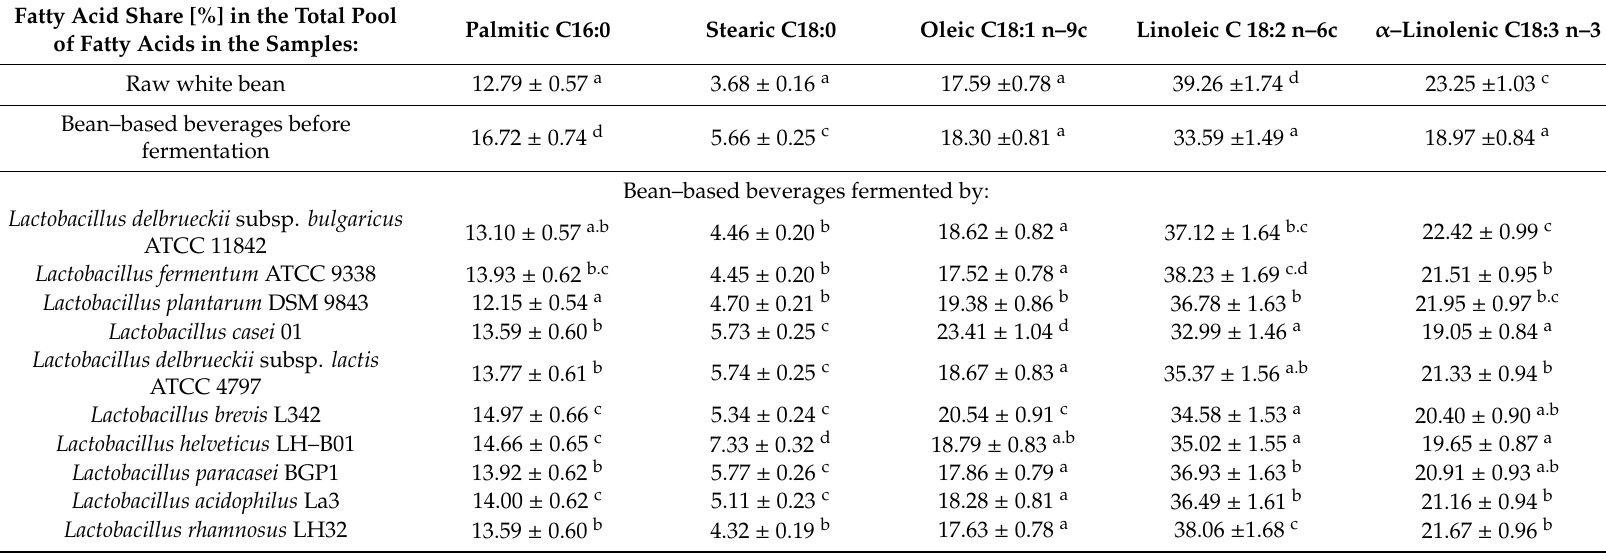
Table 2. The fatty acids profile of the raw white bean “Pi˛ekny Ja´s Karłowy” seeds and the obtained bean-based beverages (means ± standard deviations, n = 4). Fatty Acid Share [%] in the Total Pool of Fatty Acids in the